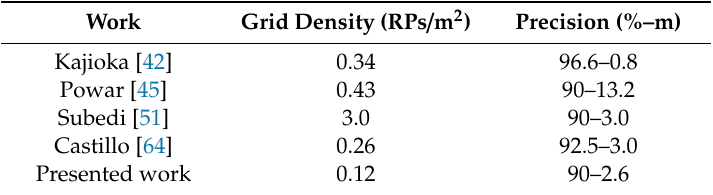
Table 33. Precision comparison between di ff erent works including our